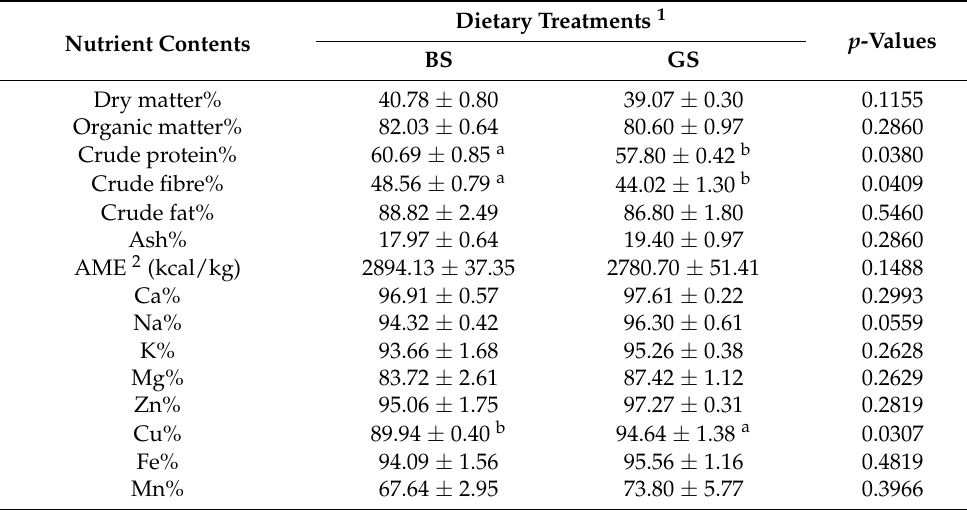
Table 5. AME and AID of DM, OM, CP, CF, EE, ash and minerals contents in broiler chickens fed seaweed.